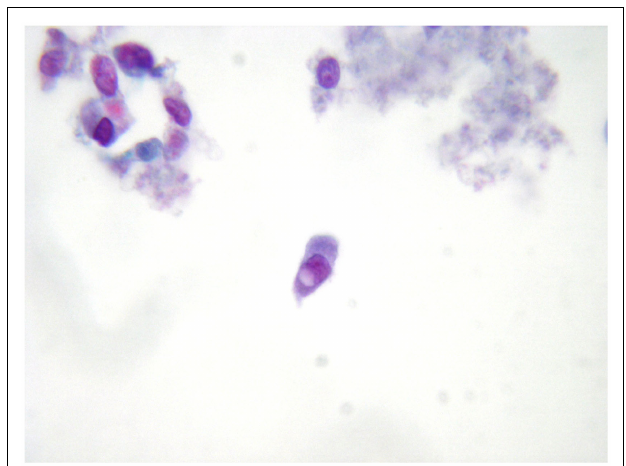
FIGURE 2 |A distinctive nuclear pseudoinclusion in a fine-needle aspiration biopsy from a thyroid papillary carcinoma (LBC, Papanicolau, 400 ×